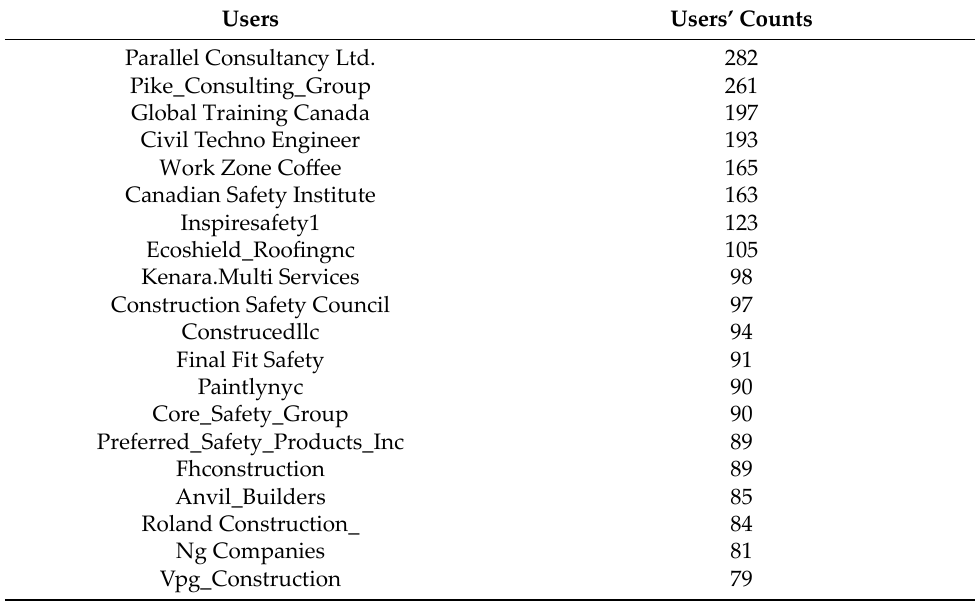
Table 3. Influential users on construction health and safety on Instagram.